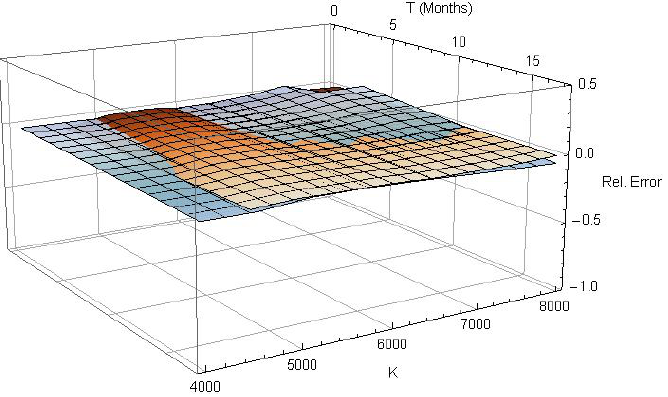
Figure 2. Relative pricing error of European plain vanilla calls (blue) and puts (red) for K a = 2, K b = 2 and n =